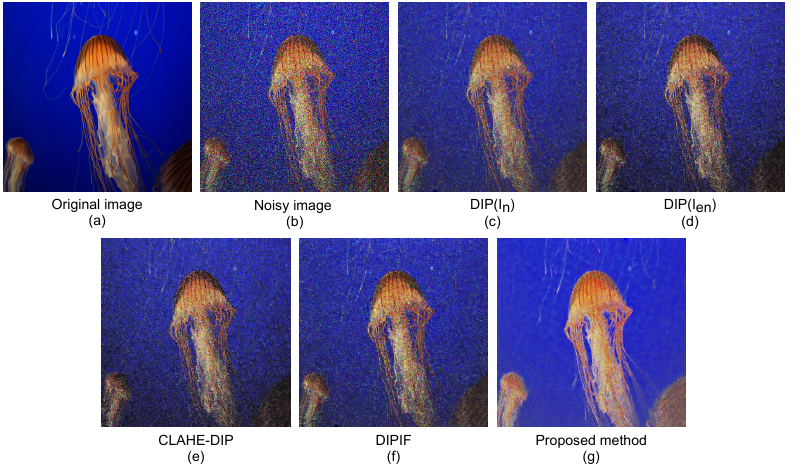
Figure 6. Noise-free images produced by our proposed method and competitive denoising methods on a “jellyfish” image with 60% noise corruption. ( a ) Clean image, ( b ) noisy image I n , ( c ) image restored by the DIP method using the original noisy image I n for supervision, ( d ) image restored by the DIP method using enhanced noisy image I en for supervision, ( e ) image restored by the CLAHE- DIP method, ( f ) image restored by the DIPIF method, and ( g ) image restored by our proposed method.